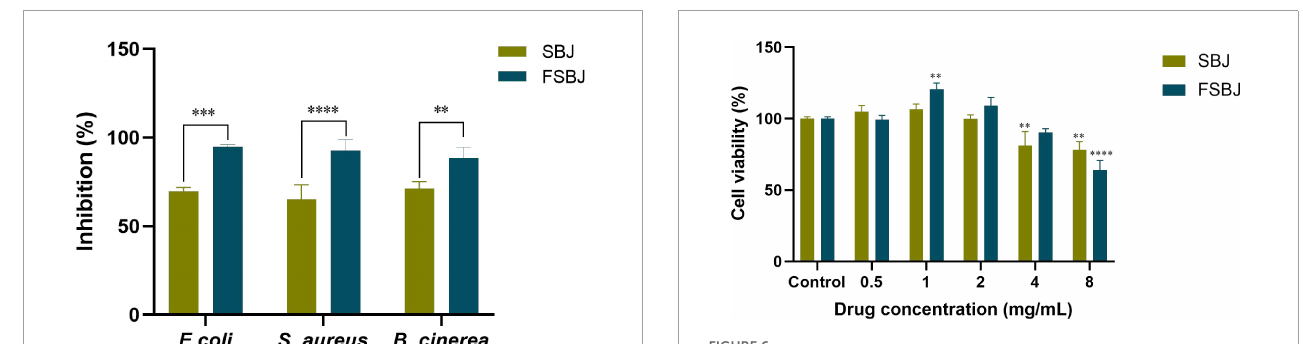
FIGURE6 Effects of different concentrations of SBJ and FSBJ on cell survival rates compared to the control group (** p < 0.01, **** p < 0.0001).